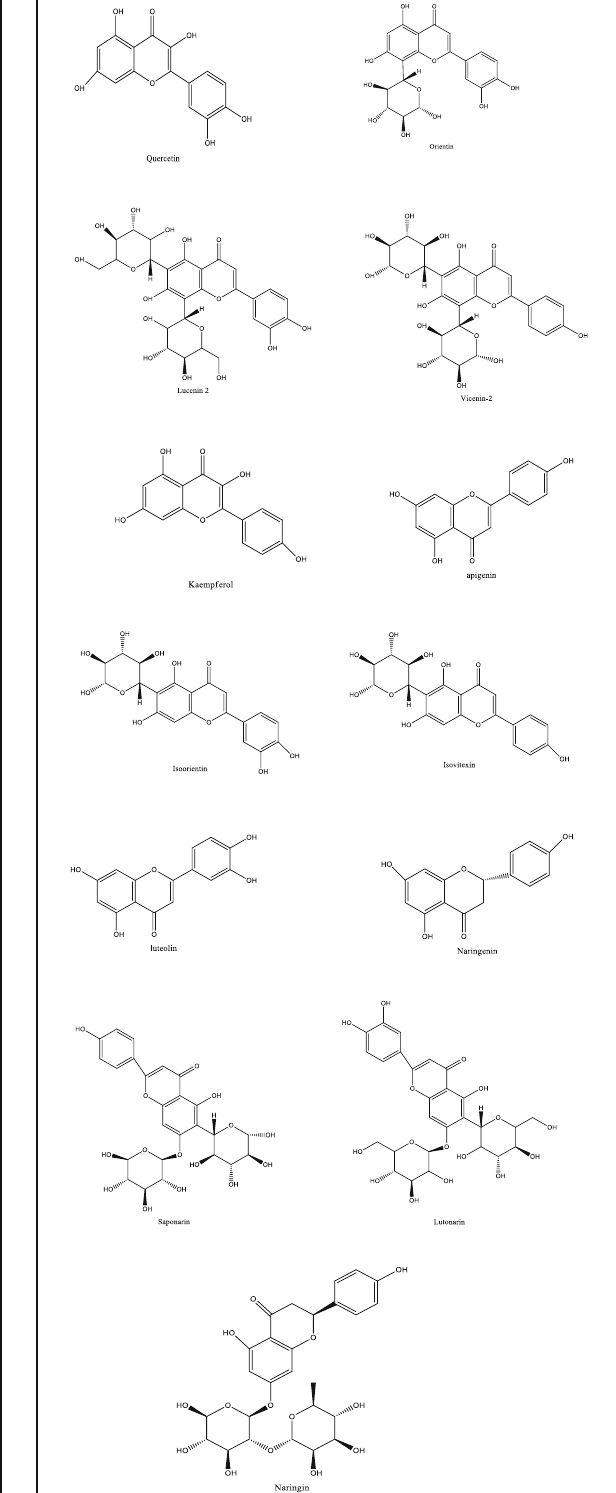
Fig. 3 Chemical structures of anthrones isolated from A. vera and A. ferox